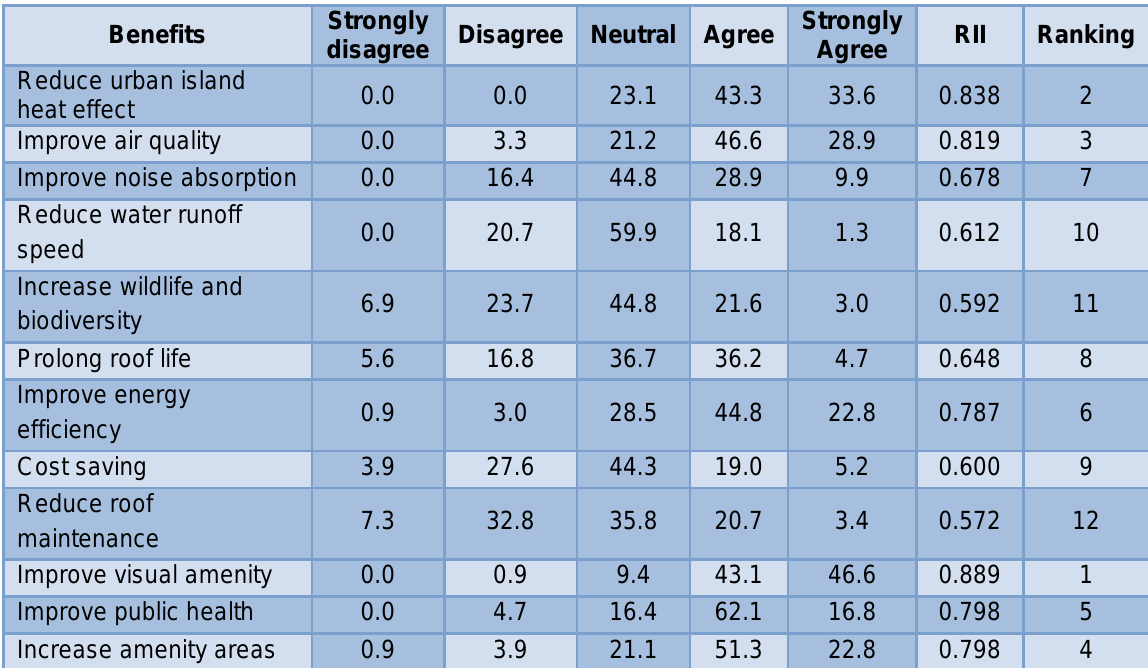
Table 7 Benefits in Implementing Extensive Green Roof